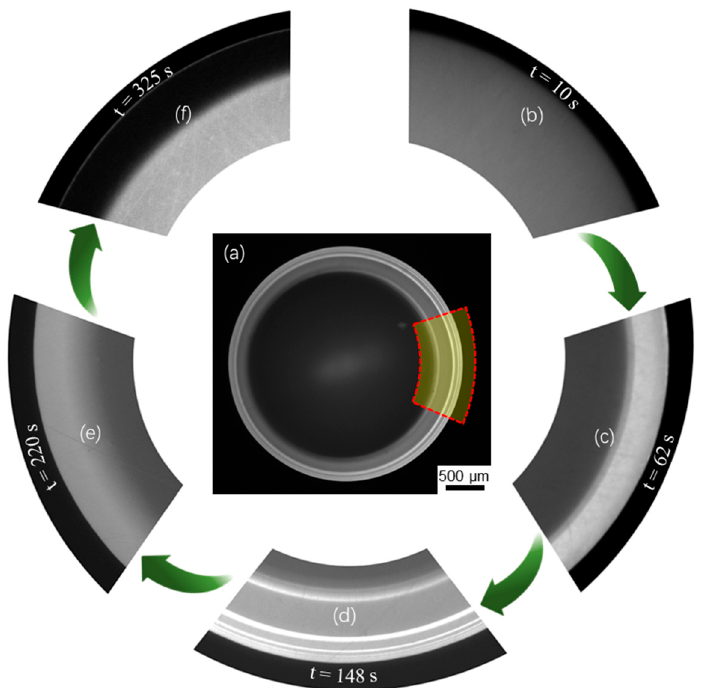
Figure 2. Evaporation dynamics of an evaporating sessile water drop from the top view. ( a ) a fluorescence fringe pattern of the whole drop captured at an instant ( t = 148 s), where the grey value is used to indicate local temperature. ( b – f ) the captured images in the selected region as highlighted in ( a ), showing the evolution of the fringe pattern at five distinctive stages corresponding to t = 10 s, 62 s, 148 s, 220 s and 325 s.